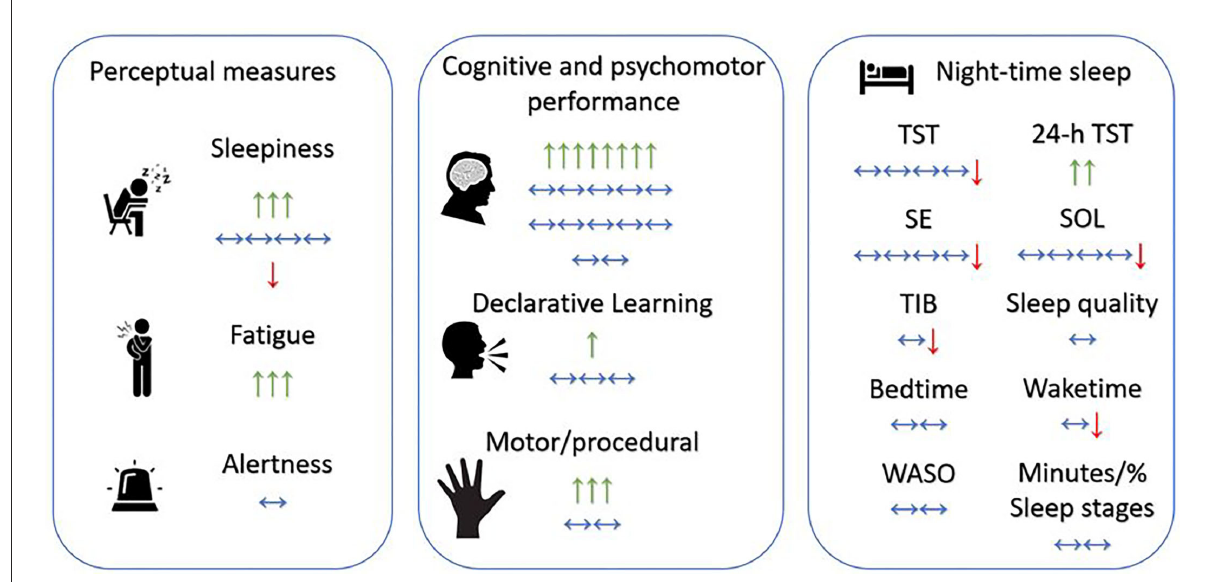
FIGURE2 Overview of the effects of daytime napping on older adults. Green arrow up ↑ , positive significant effect of one study/one nap duration (e.g., positive effect on sleepiness/fatigue means nap reduced sleepiness/fatigue); Red arrow down ↓ , negative significant effect of one study/one nap duration (e.g., negative effect on sleepiness means nap increased sleepiness); horizontal-two-edged arrow ↔ , no significant effect of one study/one nap duration; SE, sleep efficiency; SOL, sleep onset latency; TIB, time in bed; TST, total sleep time; WASO, wake after sleep